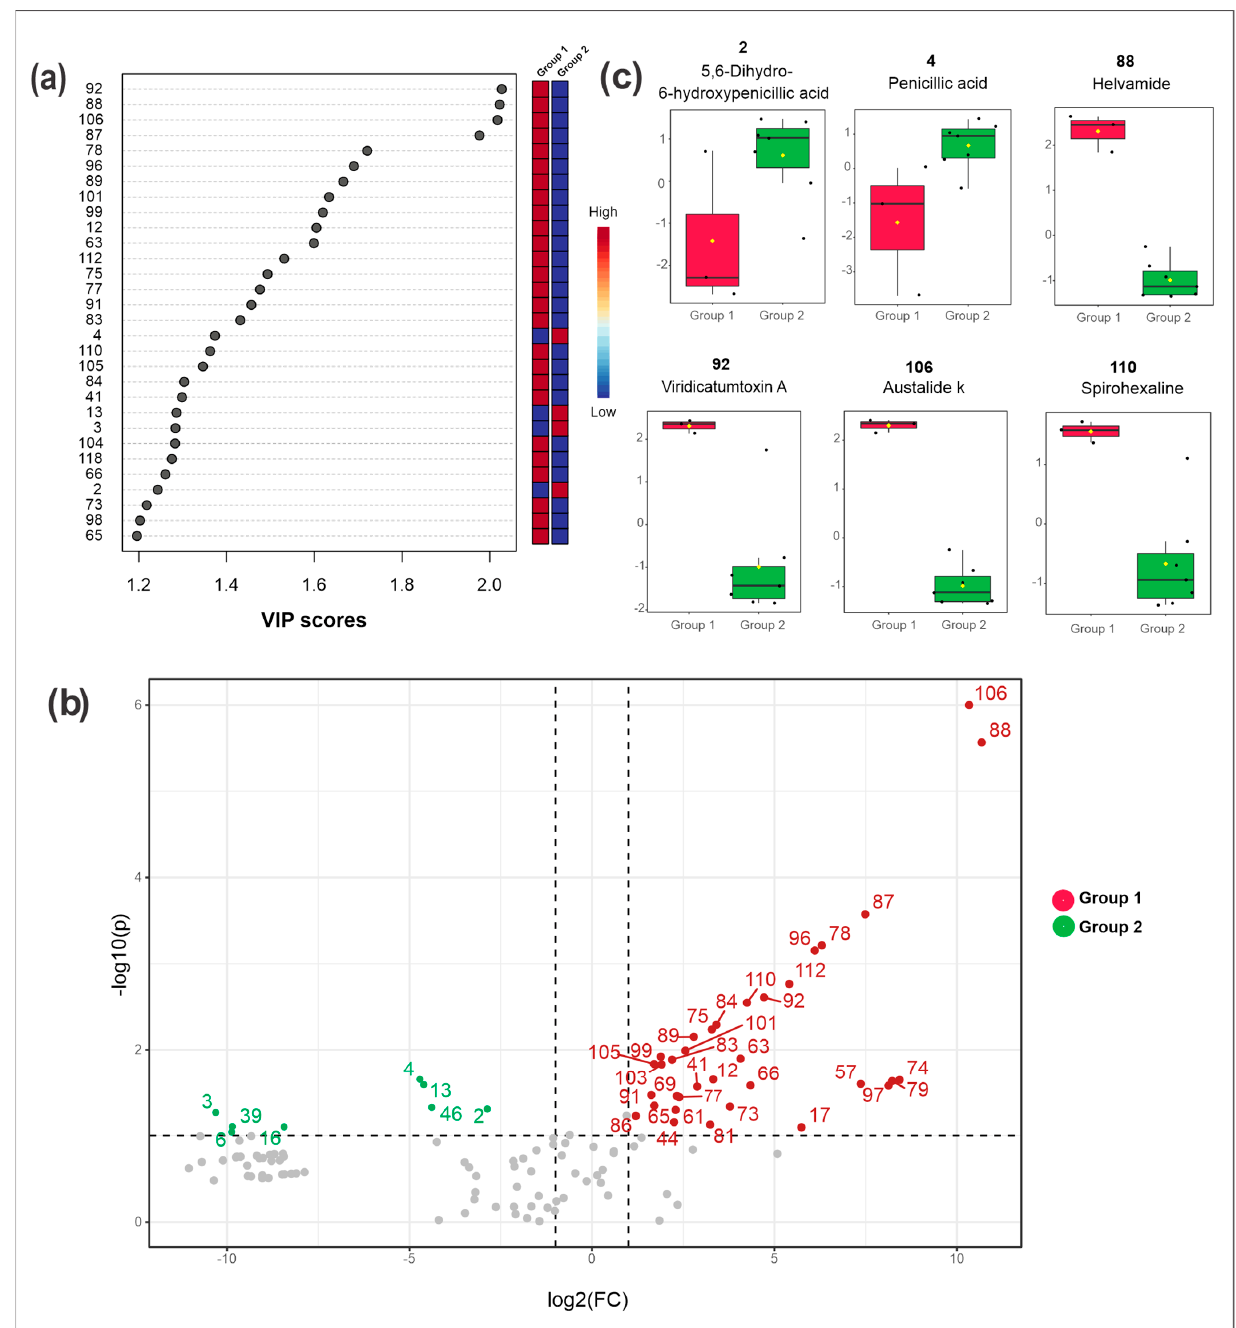
Figure 3. Metabolomics and statistical analyses from Penicillium sp. 5MP2F4. ( a ) Variable importance in projection (VIP) scores obtained by PLS-DA; ( b ) Volcano plot displaying the differences in metabolic profiles between the moderately active (represented in the left quadrant) and active (right quadrant) extracts. The x and y axes represent, respectively, the log2 of the quantitative variation of compounds (fold change, FC) and the − log10 of the p-value of all metabolites; ( c ) Box plots with the average distribution of ion intensities from the metabolites 2 , 4 , 88 , 92 , 106 and 110 . Group 1 (red): samples with higher antibacterial activity; Group 2 (green): samples with lower antibacterial activity; CEm: crude extract from mycelial biomass and CEb: crude extract from broth cultured in different media (PDB, MEB, CZA, and YPD).